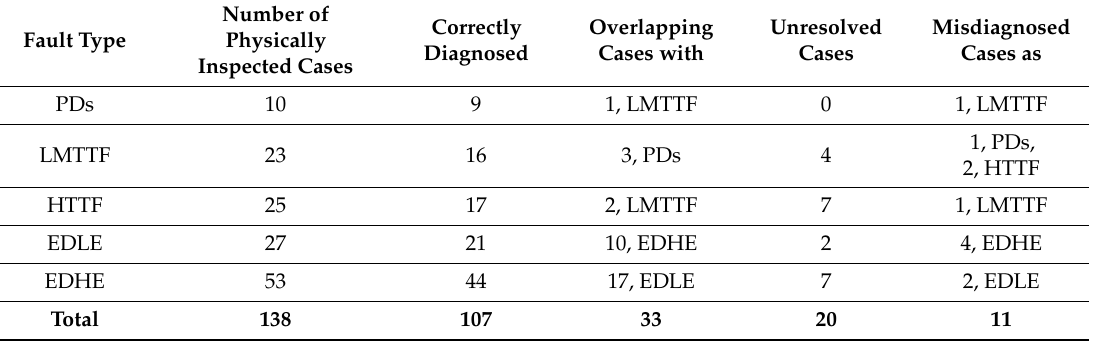
Table 7. Identification of faults using the IEC60599 technique.